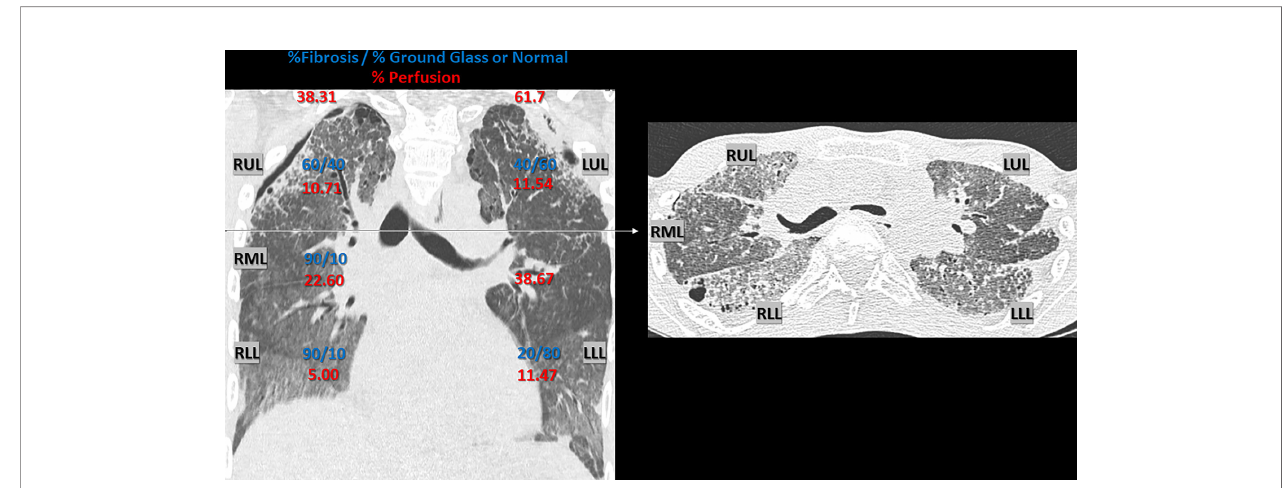
FIGURE 1 | Chest CT Scan 1 year pre-lung transplant. Chest CT Scan 1 year pre-lung transplant (2016), with representative coronal and axial section, demonstrating interstitial lung disease, with parenchymal fi brosis and ground glass opacities, due to alveolar lipoproteinosis caused by hereditary pulmonary alveolar proteinosis. Radiologic signs of irreversible fi brosis included thickening of intra- and interlobar septae (reticulation), traction bronchiectasis and honeycombing. Architectural distortion was more prominent in the anterior en apical lung fi elds compared to the postero-basal lung fi elds. A secondary spontaneous partial pneumothorax was present, situated bilateral apico-lateral (dehiscence: left side 8 mm and right side 5 mm). An estimate of the ratio (%) fi brosis vs . ground glass opaci fi cation or normal appearing lung parenchyma per lobe is given in blue (visual scoring by a skilled chest radiologist with expertise in pulmonary fi brosis). The respective perfusion (%) of each lung and individual lobe is given in red, illustrating regional differences due to hypoxic vasoconstriction. Perfusion was measured using technetium-99m radioisotope (122.0 MBq, 3.30 mCI) and Pulmonics software. RUL, right upper lobe; RML, right middle lobe; RLL, right lower lobe; LUL, left upper lobe; LLL, left lower